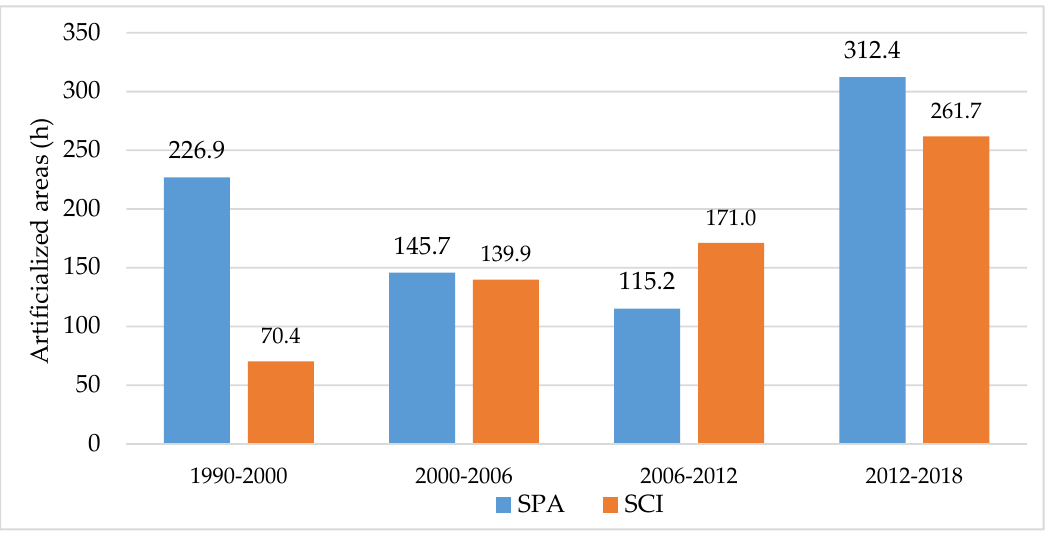
Figure 21. Artificialized areas.